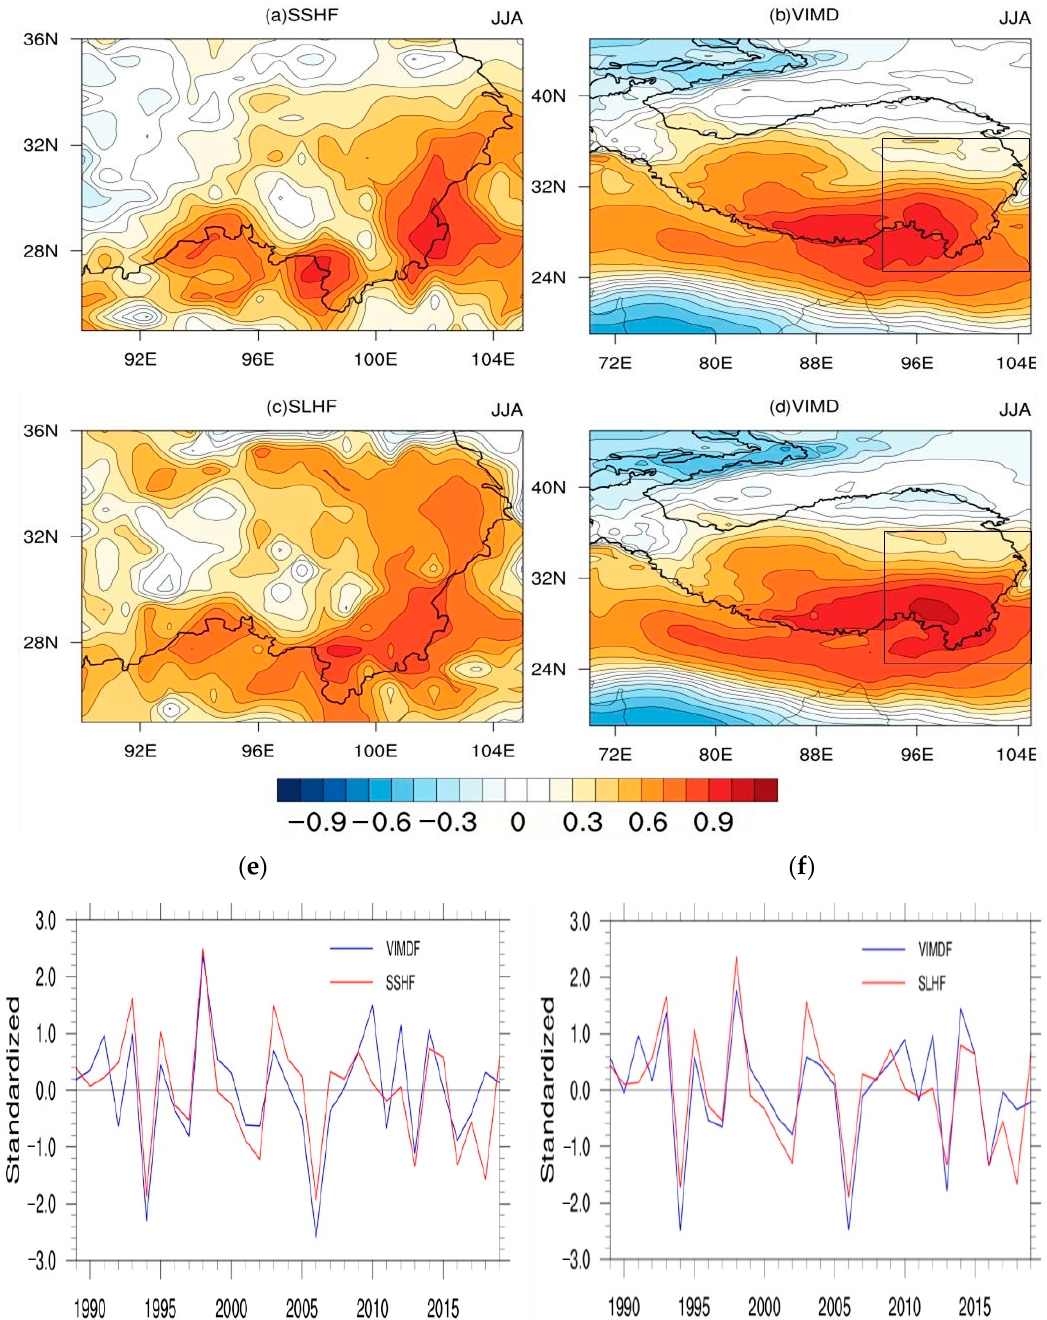
Figure 11. ( a – d ) SVD analysis and ( e , f ) corresponding time series of the surface flux field and eastward water vapor flux field in southeastern Tibet during the AMS. ( a ) the first mode of the thermal field; ( b ) the first mode of the eastward water vapor flux field; ( c ) the first mode of the latent heat field; ( d ) the first mode of the eastward water vapor flux field; ( e ) the sensible heat flux and eastward water vapor flux field; and ( f ) the latent heat flux and eastward water vapor flux field. The solid black line is the boundary of the Tibetan Plateau in ( a – d ). The red solid line is SSHF time series and the blue solid line is VIMD time series in ( e , f